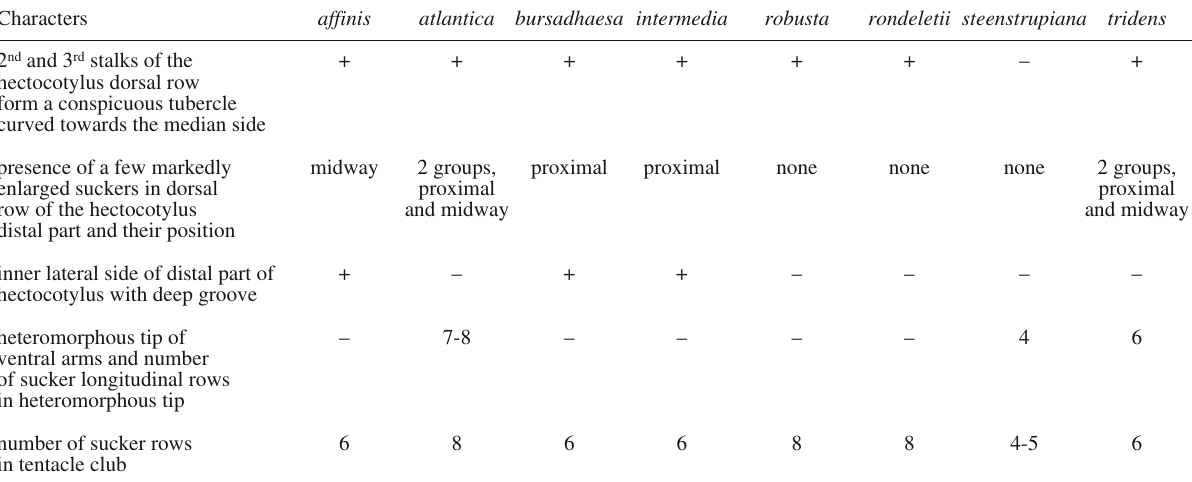
Table 2. – Key characters of the species in the Sepiola atlantica